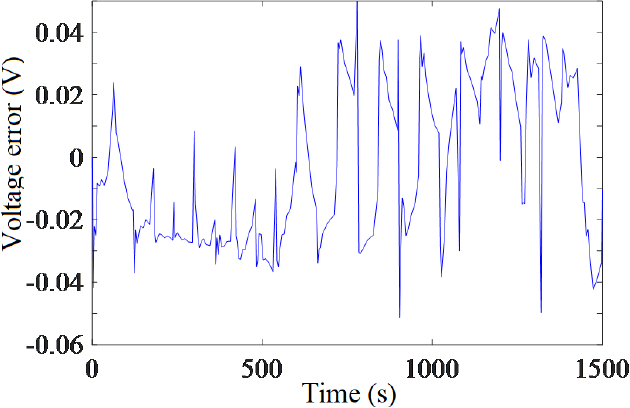
Figure 8. Comparison of output voltage between simulation and test.